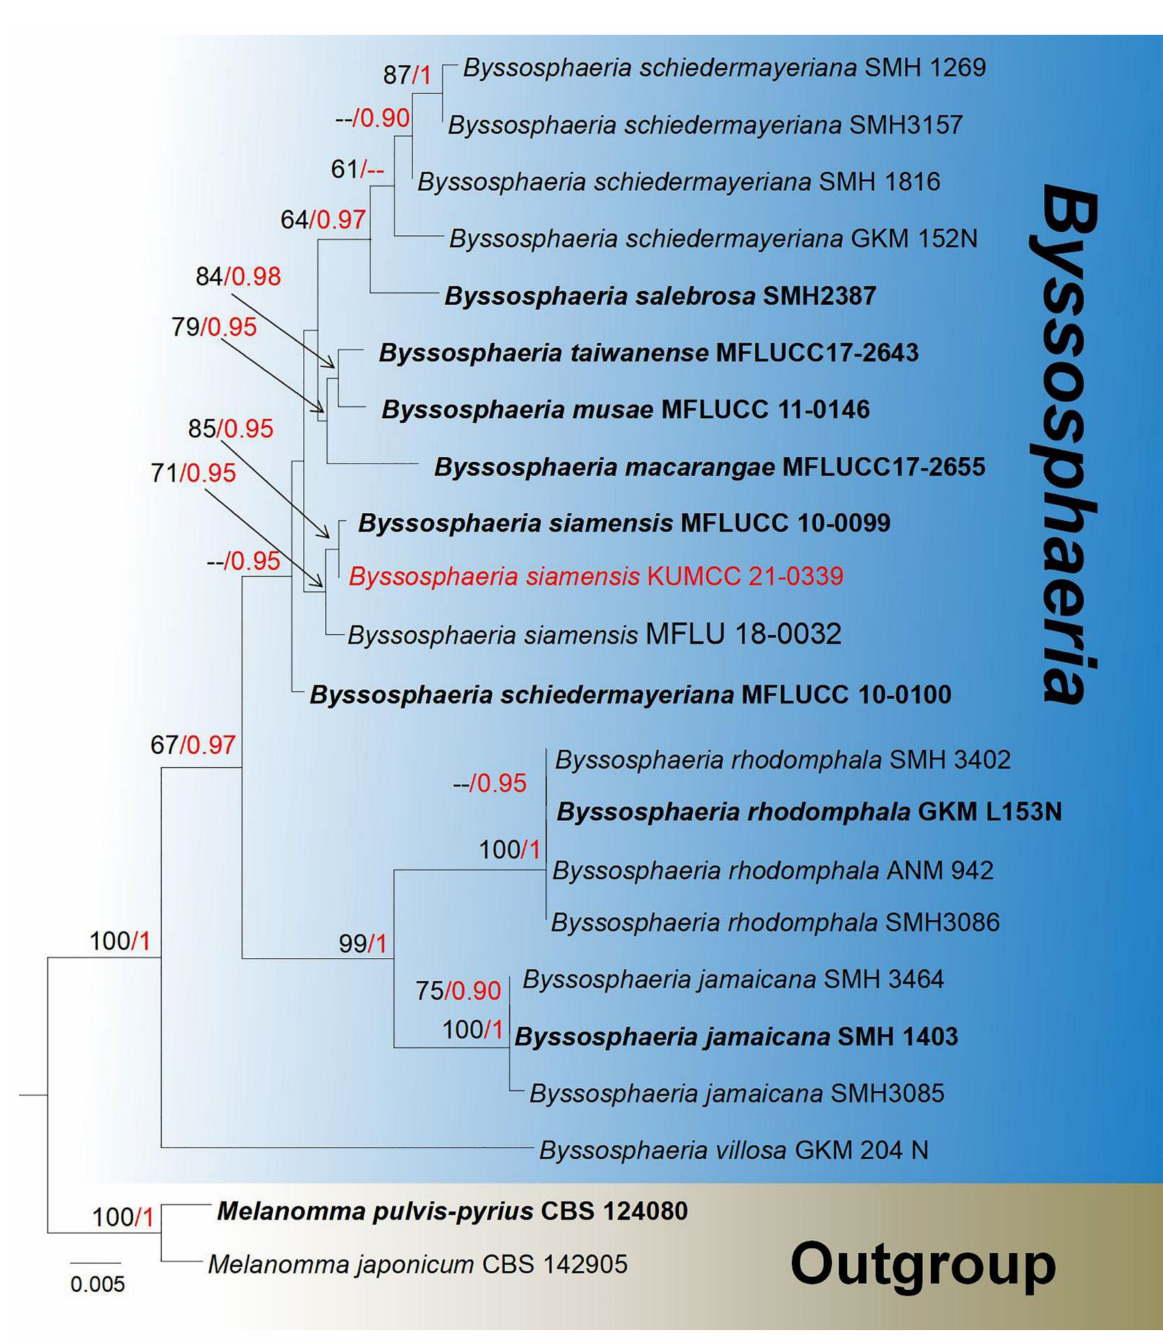
Figure 3. Phylogram generated from maximum likelihood analysis based on a combined LSU,